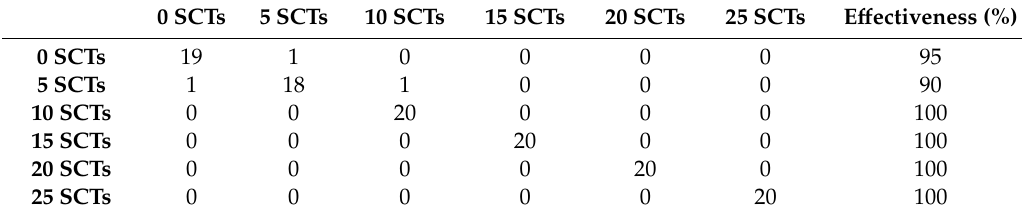
Table 3. Confusion